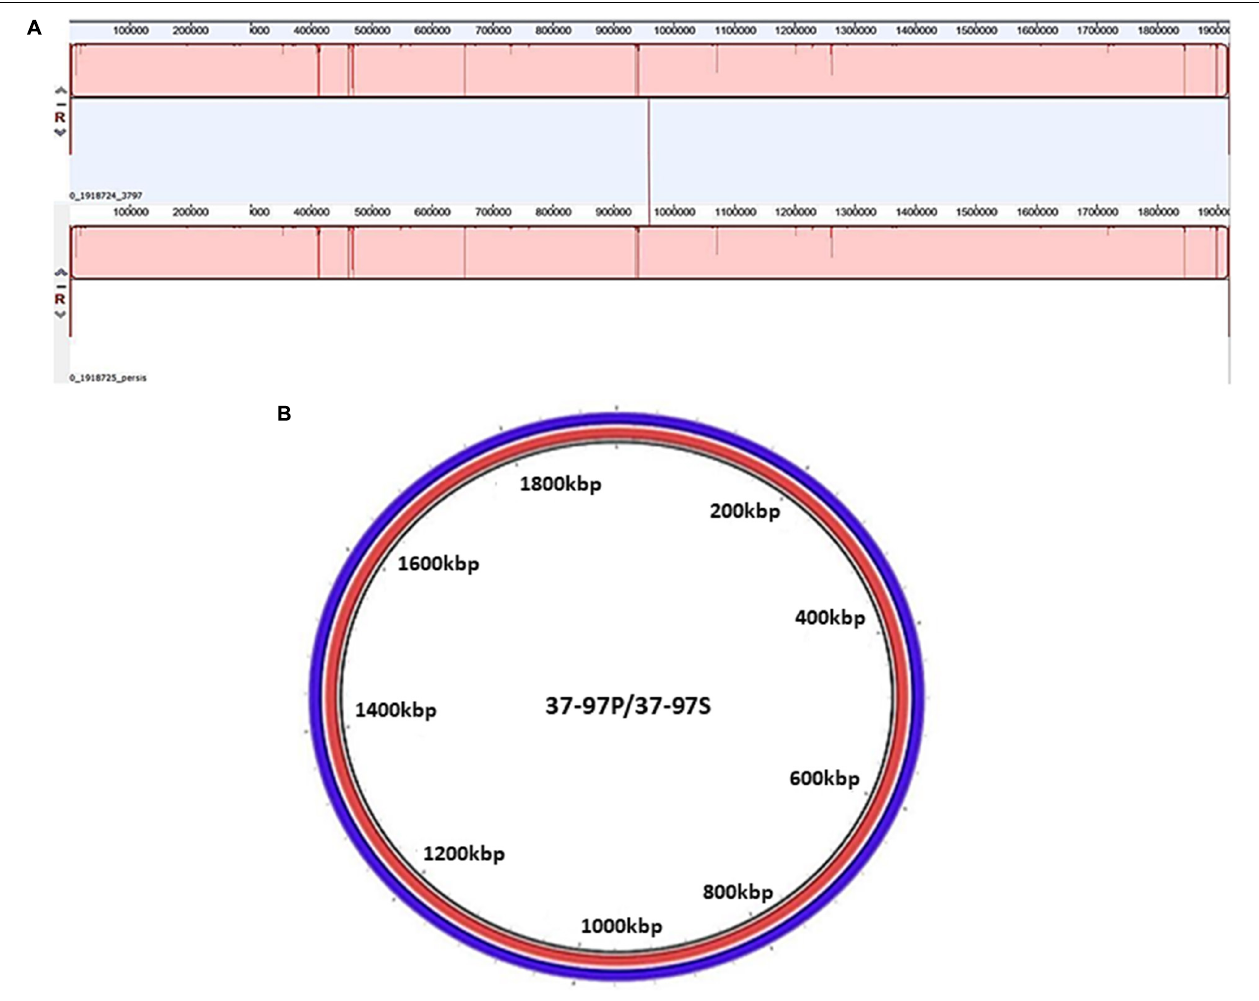
FIGURE 2 | Analysis of synteny and circular comparison of the chromosomes. (A) Genome alignments were performed using MAUVE. 37–97P : DNA sequence of the penicillin persister cells of the Streptococcus pyogenes strain 37-97 generated in 8 µ g/mL penicillin (MIC = 0.01 µ g/mL), and 37–97S : DNA sequence of the susceptible cells of strain 37–97. (B) . Circular comparison of the chromosomes was generated by Blast Ring Image Generator (BRIG) using genome sequences obtained from 37–97P (red) and 37–97S (blue)